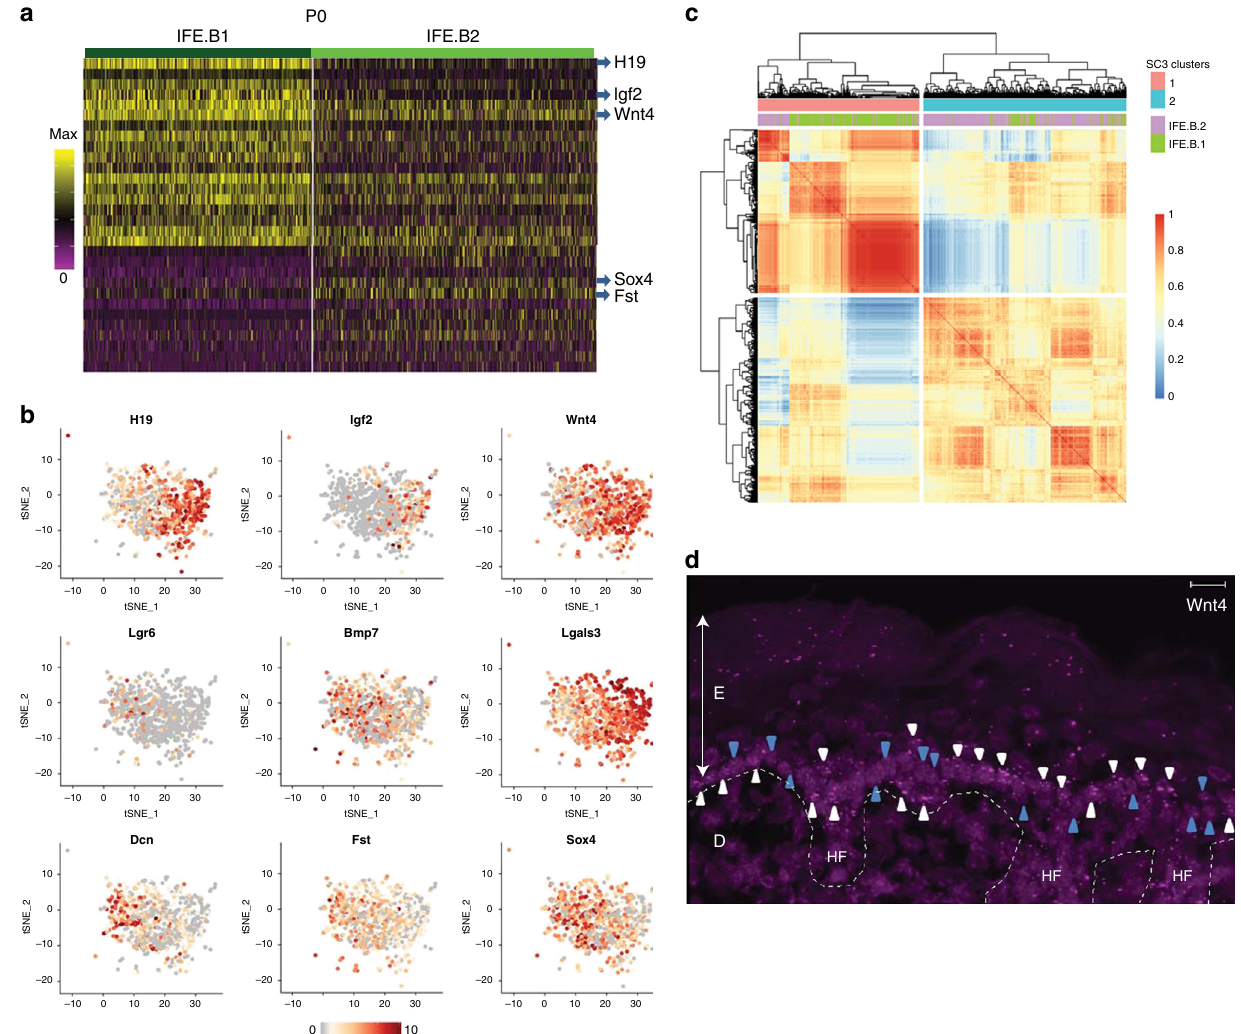
Fig. 2 The P0 IFE basal cell layer contains two distinct cell populations. a Expression heatmap of unique gene signatures for each of the two basal IFE clusters. Blue arrows highlight select differentially expressed genes between the two basal clusters. Gene lists in Supplementary Data 1. b Expression level of select genes, which are enriched in either IFE.B1 or IFE.B2, projected onto tSNE for the two basal clusters. c Heatmap showing the correlation between cells for SC3 clustering (1, 2; red, blue) and Seurat clustering (IFE.B1, IFE.B2; purple, green). d RNA-FISH for Wnt4 in the P0 IFE. White arrowheads, Wnt4- high cells; blue arrowheads, Wnt4 -low cells; white broken line, basal lamina; E epidermis, D dermis, HF hair follicle. Scale bar = 10 µ m, representative image for N =